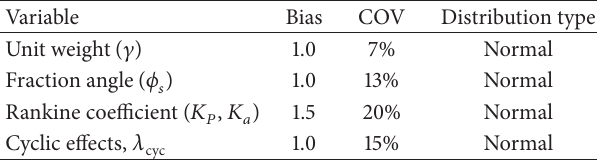
Table 2: Backfill Soil related statistics